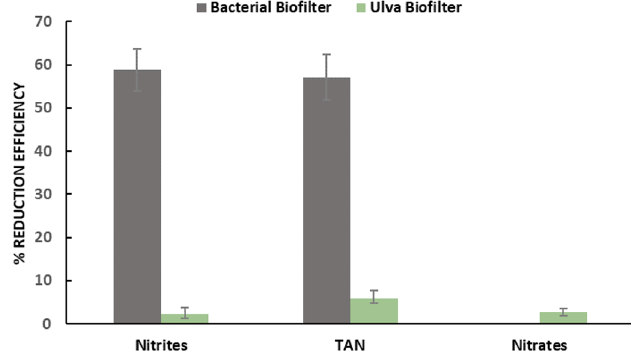
Table 2. Mean values (±SE) of body weight (W), total length (TL), standard length (SL), fork length (FL) and Fulton ’ s condition factor (K) of